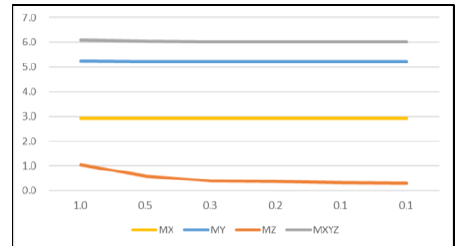
Figure 6. Influence of range error